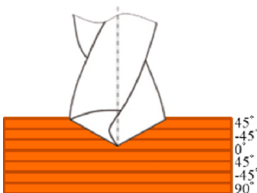
Figure 9. Diverse simultaneous fiber orientations along the cutting edge.